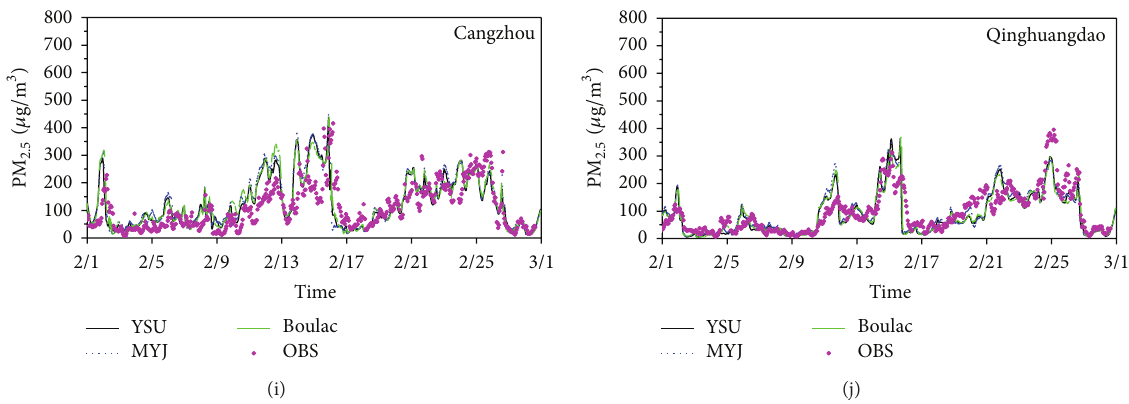
Figure 3: Simulated and observed hourly PM 2.5 concentration at 10 sites ((a)–(j)) in February 2014.